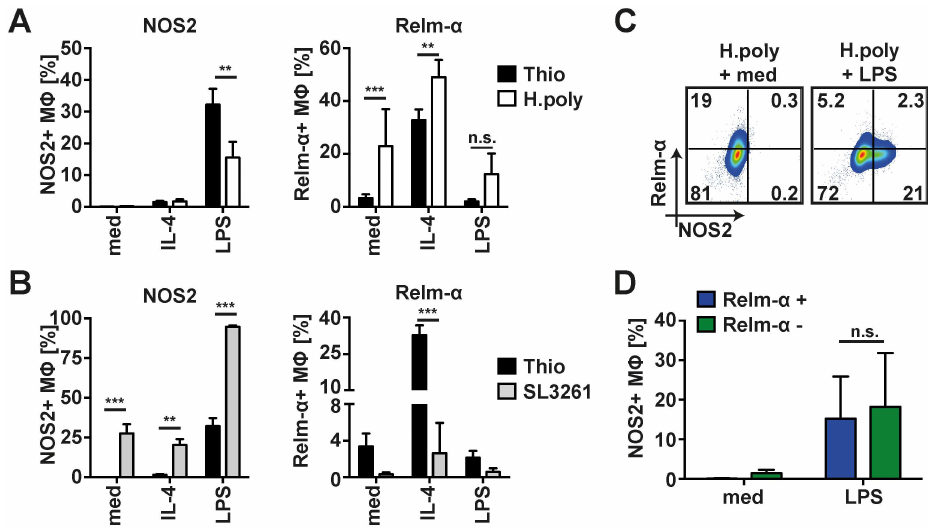
Fig 1. H . polygyrus derived peritoneal M Φ can be re-polarized to express NOS2 in vitro. (A) In vitro stimulationof wholePEC isolated14 days after H . polygyrus infectionand stimulatedwith rIL-4 (IL-4), LPS (LPS) or without additionalstimulus (med) for 24h. Thioglycollate-elicitedM Φ were used as control. Expression of intracellular NOS2 and Relm- α in CD115+CD11b+M Φ measured by flowcytometry. (B) As A using whole PEC isolatedfrom S . enterica ser. Typhimurium (SL3261)infectedanimals14 days after infection. (C) Representative dot plots of NOS2 expressionversus Relm- α expression in M Φ (CD11b+CD115+) isolatedin A. (D) Quantification of the data depictedin C representing NOS2 expressionin Relm- α positive(blue)or negative(green)M Φ from H . polygyrus infectedanimals.Bars depict mean and SEM of 4–5 animalsper group. One representative experiment of three depicted. ** :p < 0.01, *** ;p < 0.001;n.s.: not